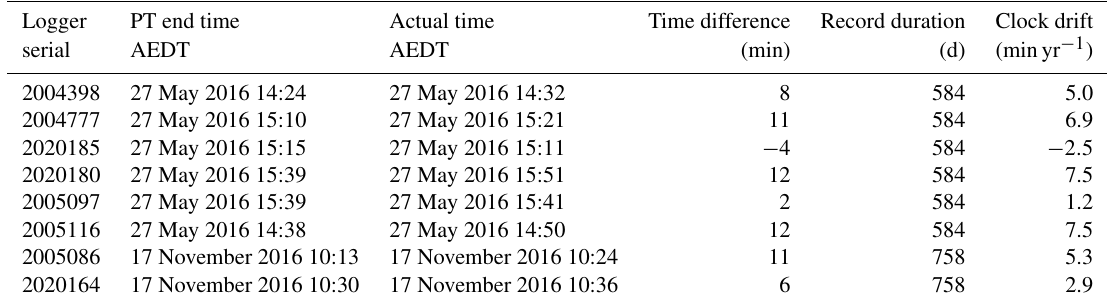
Figure 9. Water level versus time for a piezometer in the Netherlands that had a clogged well screen until it was rehabilitated in June 1996 (Willemsen, 2006). The temporal dynamics of the head in the aquifer were not registered by the piezometer until that time. Data were obtained from http://www.dinoloket.nl (last access: 16 January 2019). Table 2. Example of an assessment of clock stability for eight different standard PTs (AEDT is Australian eastern daylight time). None of the PTs complied with the clock stability of ± 1minyr − 1 , as specified by the